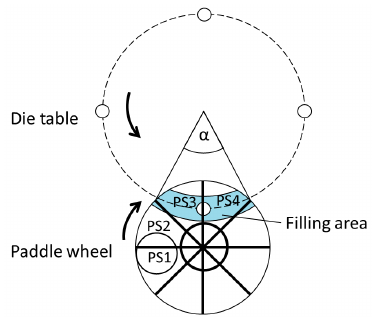
Figure 2. Schematic overview of the four process steps for die filling in a one-paddle feed frame. The paddle rotates clockwise, the die table rotates counter-clockwise.